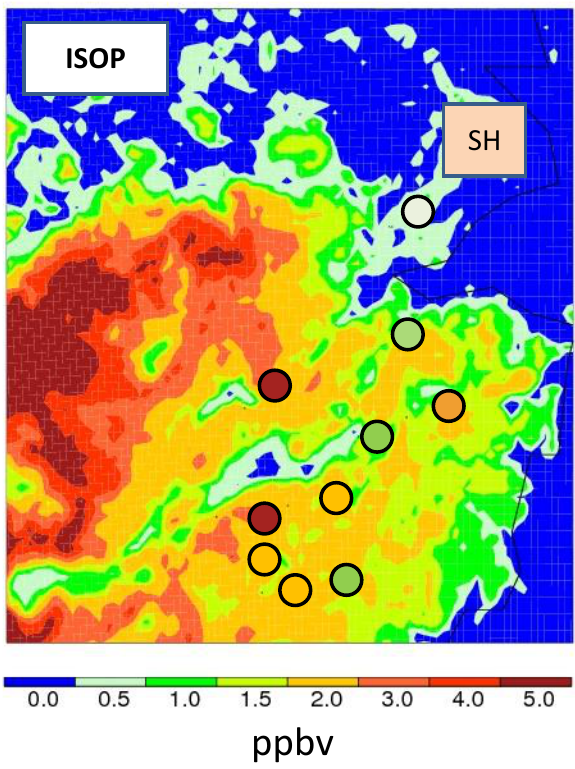
Fig. 2. Comparison of the calculated isoprene concentrations (ppbv) Figure 2, Comparison of the calculated isoprene concentrations (ppbv) with the with the measured values (shown in the color filled circles). The measured values (shown in the color filled circles). The measured values are averages measured values are averages obtained between 9:00 and 15:00 on obtained between 9:00 and 15:00 on September 4 and 5, 2009. 4 and 5 September 2009.